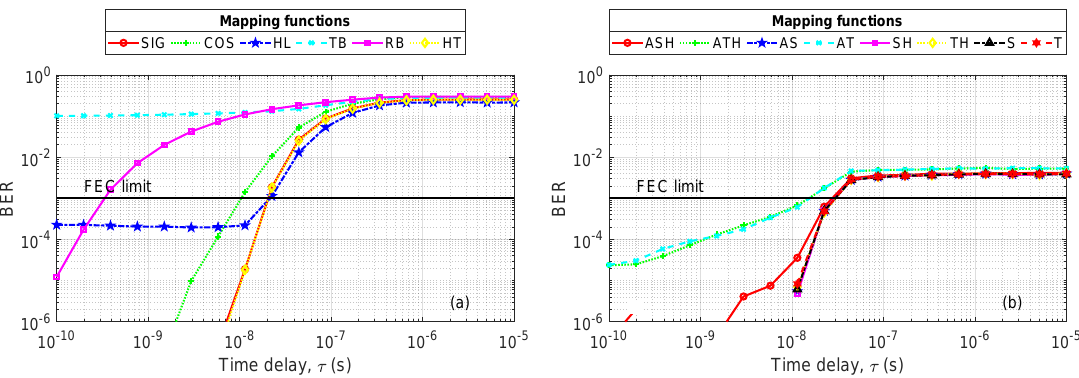
Figure 6. With the best number of hidden neurons, the system performance as the combined fields become phase-decorrelated with the activation function as the parameter for ( a ) real and ( b ) complex ELMs.